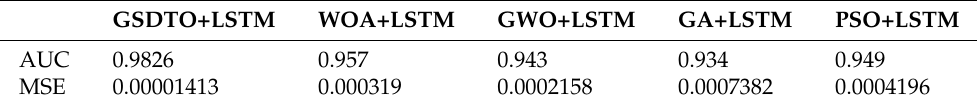
Table 11. Proposed and compared algorithms classification results based on LSTM